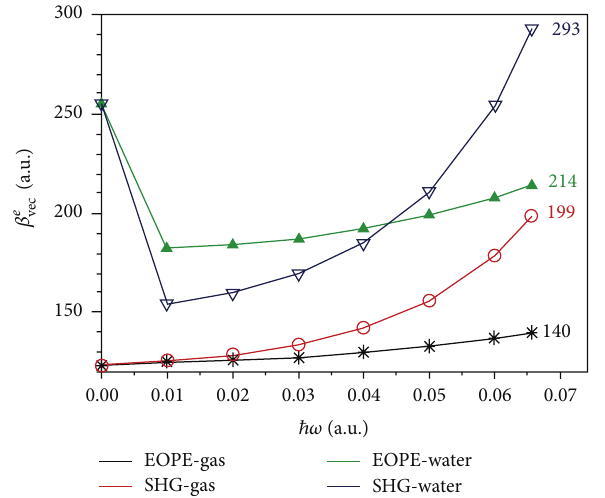
Figure4:Contributionofeachnormalmodetothevibrationalfirst- order hyperpolarizability of uracil in gas and water solution. CAM- B3LYP/aug-cc-pVDZ